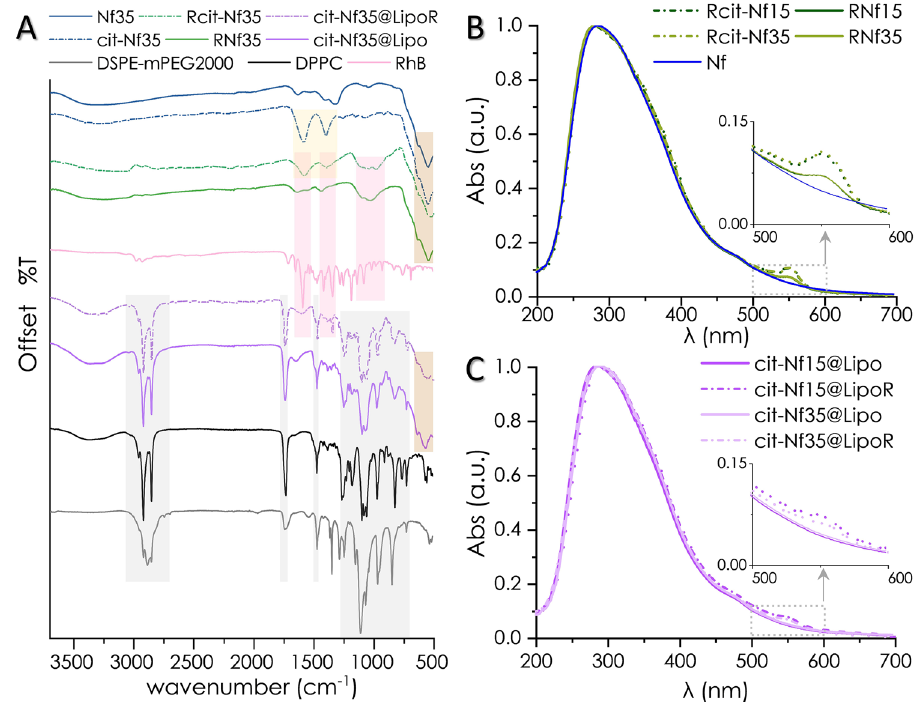
Figure 3. ( A ) Juxtaposed FT-IR spectra of all formulations where highlighted areas indicate the different functionalities (brown: iron oxide, yellow: citrate, pink: RhB, grey: lipids). ( B , C ) Observable RhB adsorbed on Nfs or loaded in liposomes in normalized UV–vis spectra at 554